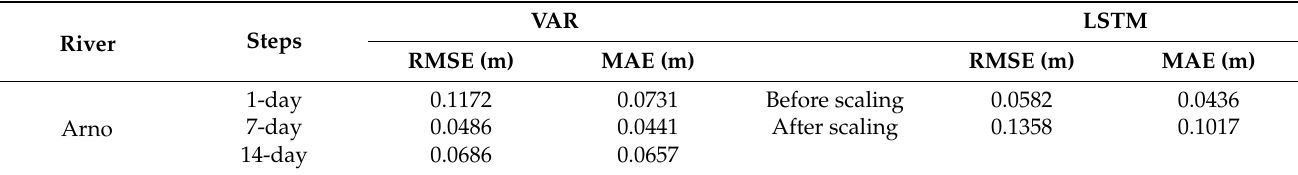
Table 3. Summary of Water Level (river).